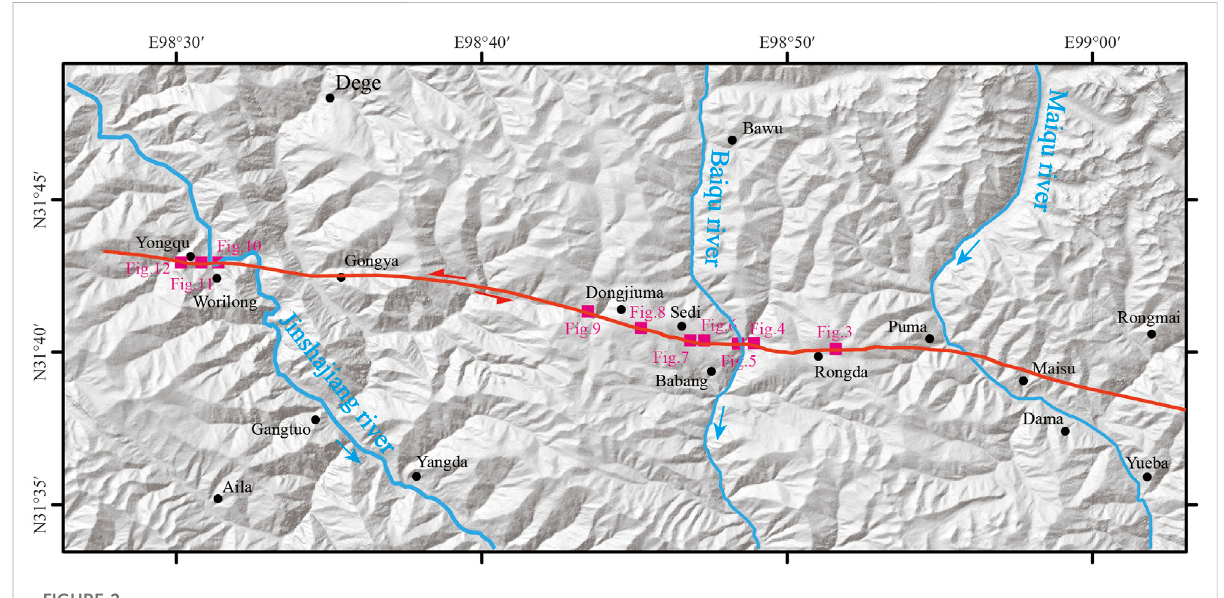
FIGURE 2 Tracks showing Holocene activity along the Maisu fault. Locations of studied sites are shown.